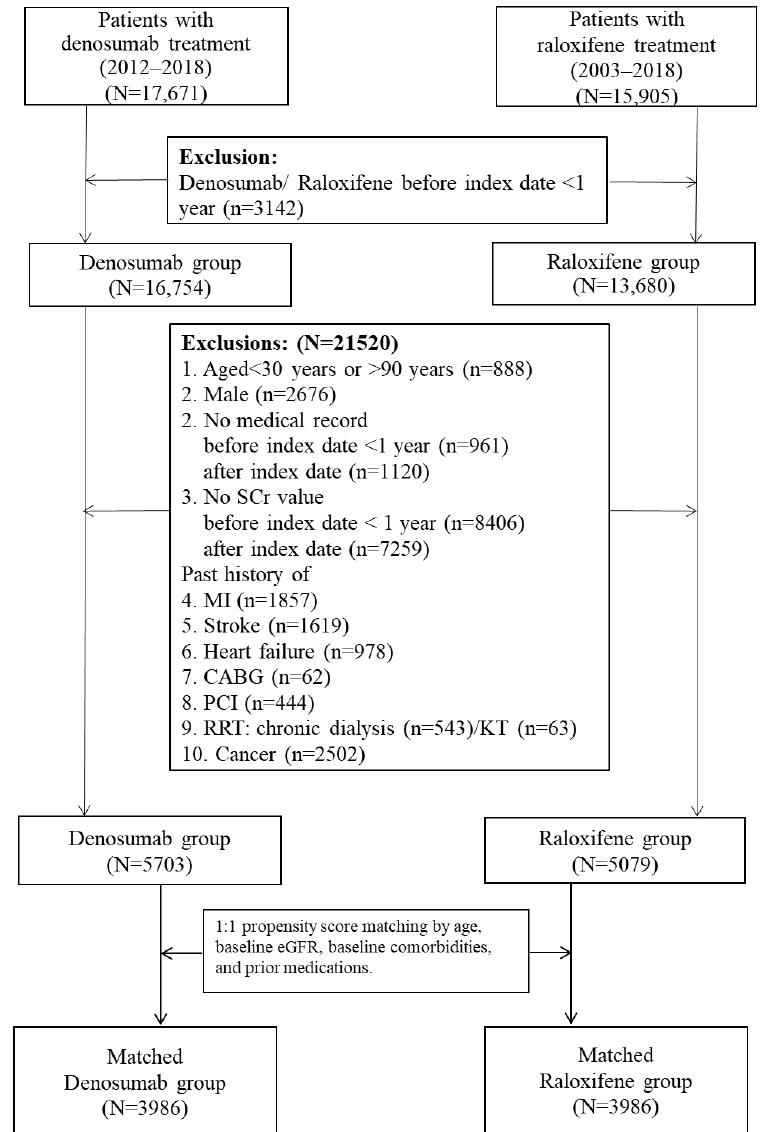
Figure 1. Study flowchart and patient selection process. Propensity score was calculated based on baseline comorbidities: peripheral vascular diseases, dementia, pulmonary disease, connective ti-sue disorder, peptic ulcer, liver diseases, diabetes, diabetes complications, paraplegia, renal disease, severe liver diseases, metastatic cancer, hypertension, hyperlipidemia, abnormal thyroid function, obstructive sleep apnea, and prior medication (oral anticoagulants, antiplatelets, aspirin, statins, fibrates, other lipid-lowering agents, anti-diabetics, angiotensin-converting enzyme inhibitors (ACEI)/angiotensinreceptor blockers (ARBs)/Aliskiren, diuretics, bisphosphonates, Forteo, and calcitonin preparations). CABG, coronary artery bypass surgery; MI, myocardial infarction; PCI, percutaneous coronary intervention; RRT, renal replacement therapy; and SCr, serum creatinine.